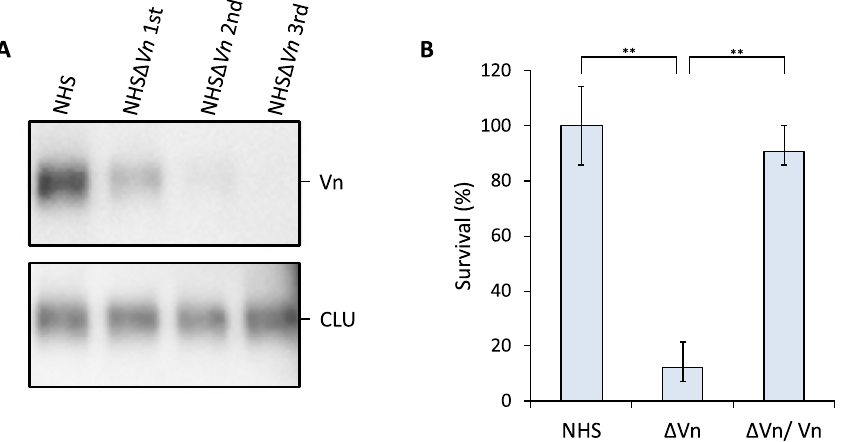
Figure 8. Vn-depleted human serum has bactericidal activity against serum-resistant B. garinii HT59G/ pBOM1093. ( A ) Serum Vn was depleted for NHS. Vn depletion from human serum was repeated three times (HSΔVn 1st, HSΔVn 2nd, and HSΔVn 3rd). Levels of Vn and clusterin (CLU) in tested sera were determined by western blotting. ( B ) Survival ratio was calculated for B. garinii HT59G/pBOM1093. ΔVn indicates the HSΔVn third sample (HSΔVn 3rd). ΔVn/Vn indicates the tested serum, which was supplemented with 1 mM of recombinant Vn to the HSΔVn 3rd. ** p ≤